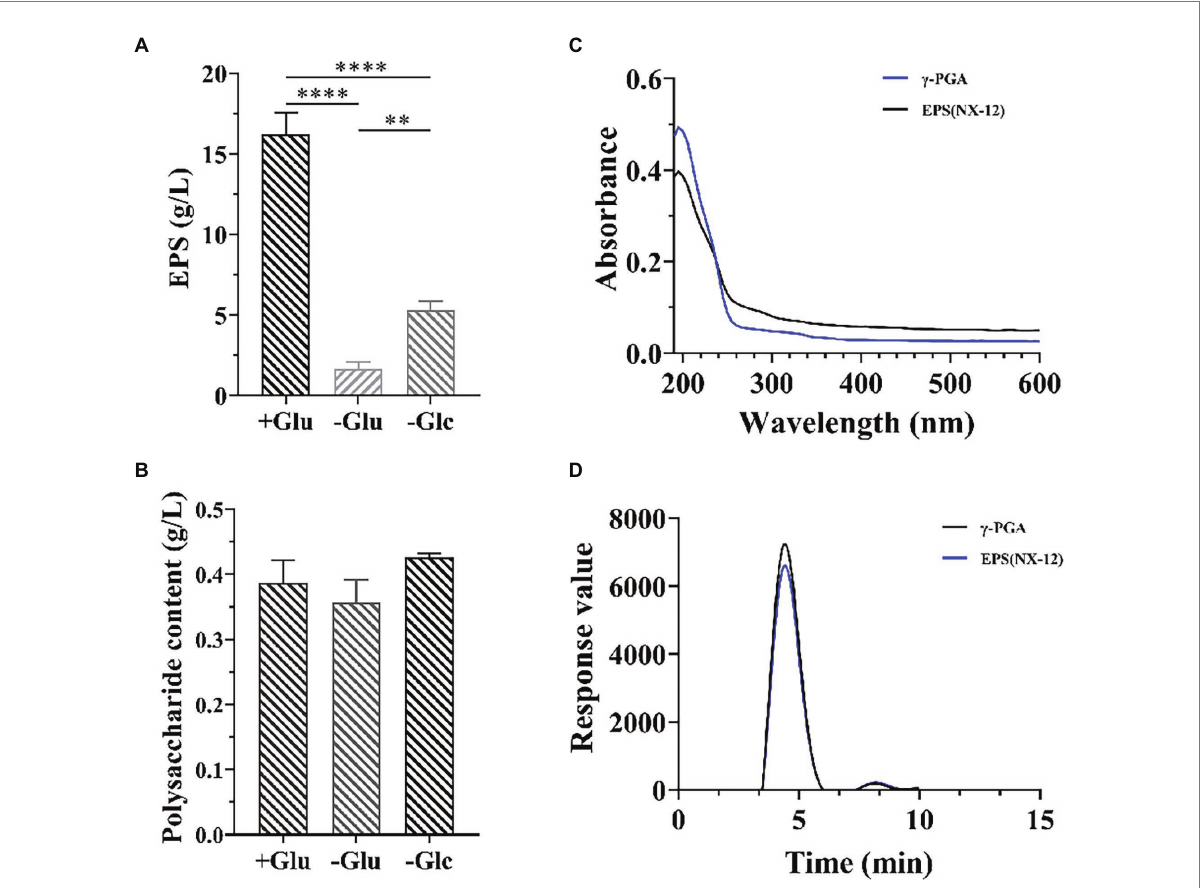
FIGURE 2 Isolation and Identification of EPS from NX-12. (A) Comparison of the production of EPSs by fermentation; (B) Comparison of the production of extracellular polysaccharide by fermentation; (C) Spectral analysis of EPS from NX-12 and γ -PGA. (D) Comparison of monomer liquid phase analysis after hydrolysis of EPS and γ -PGA; Error bars represent standard deviations. ** indicated value of p < 0.01; **** indicated value of p <